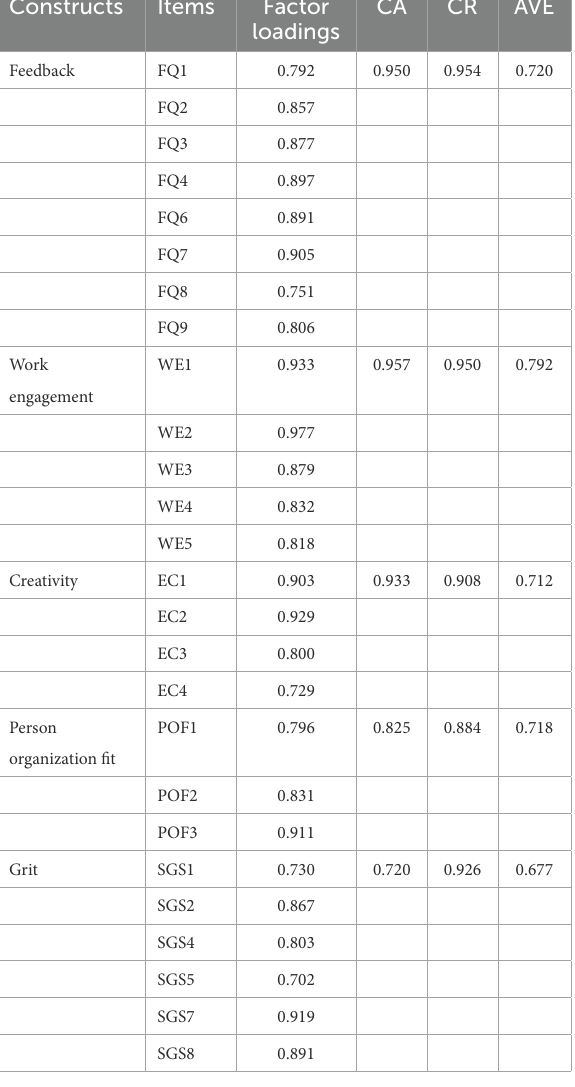
TABLE 3 Constructs measurement scale and properties.